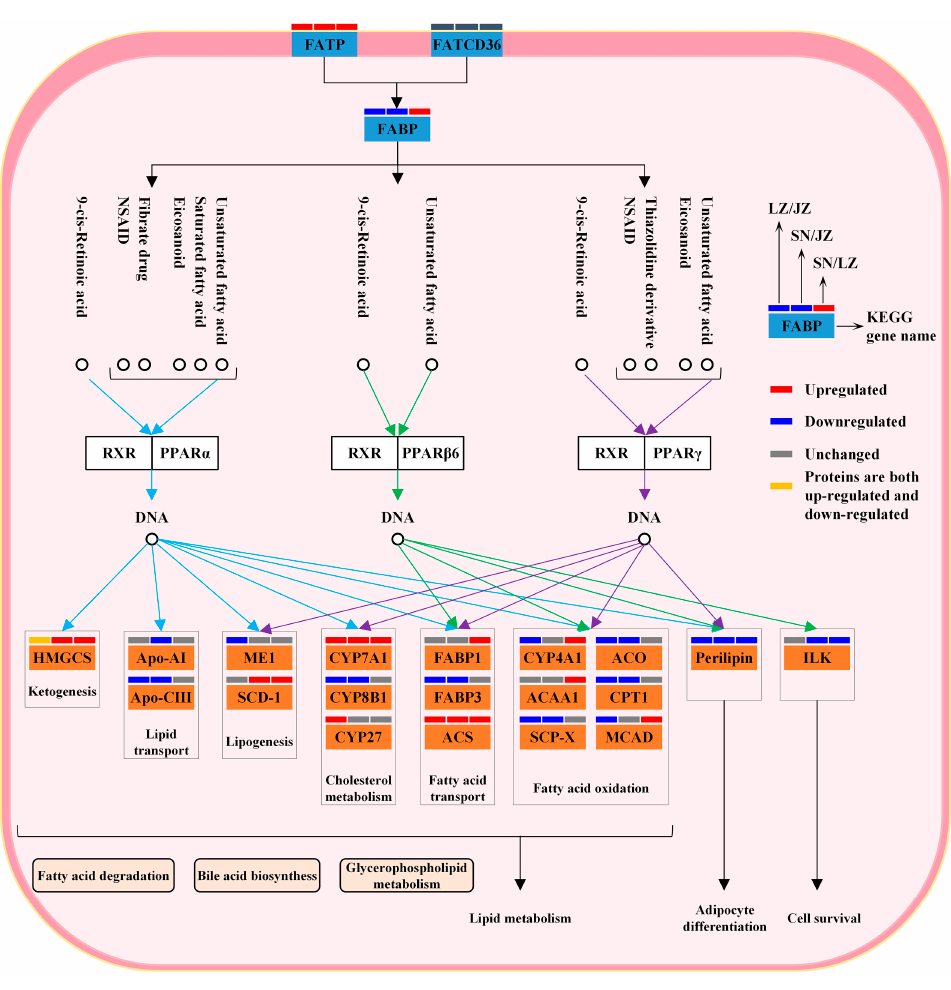
Figure 6. Expression of DEPs in “PPAR signal pathway”.